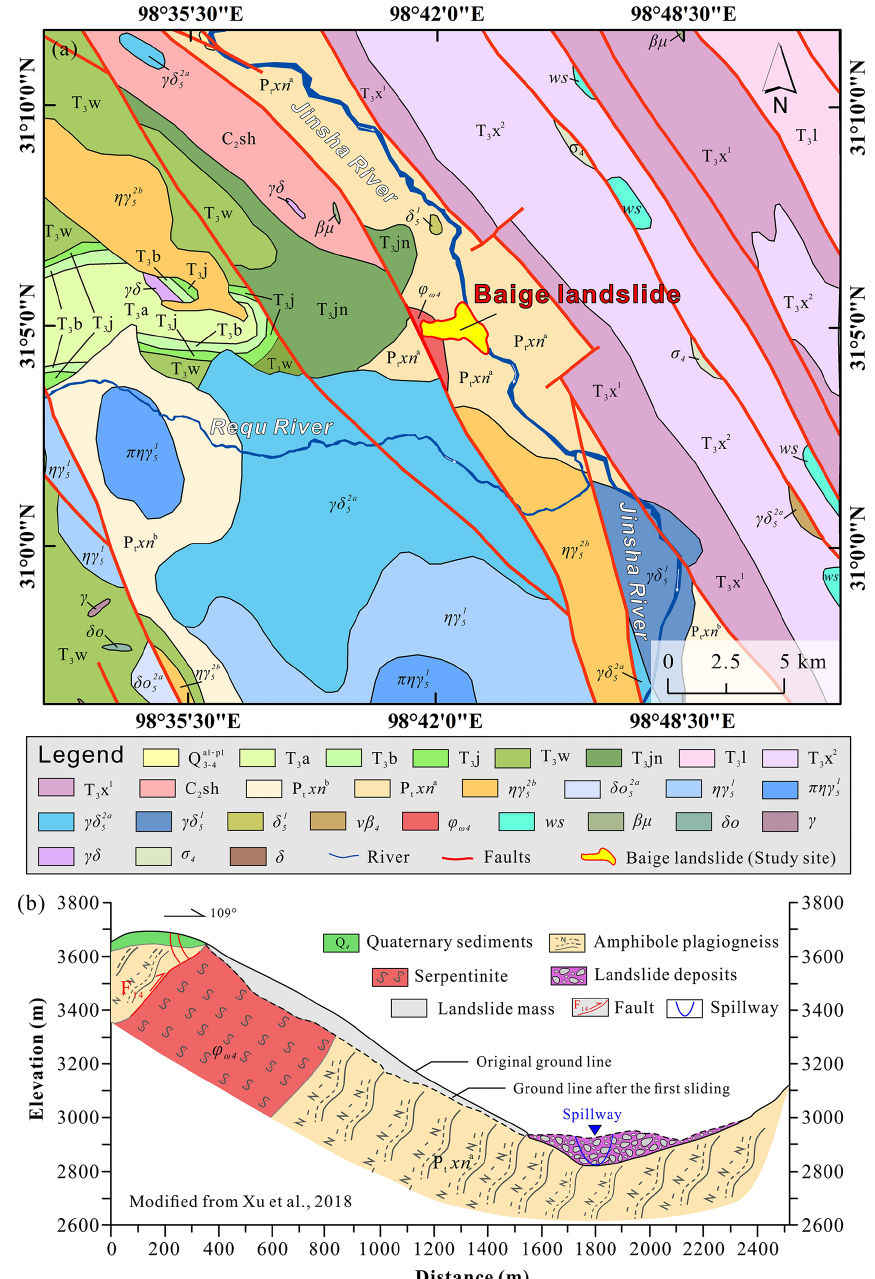
al − pl : Quaternary Holocene–Upper Pleistocene; 3 − 4 : Yanshan , δo 2 a 5 5